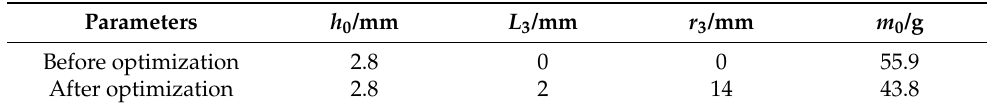
Table 6. Comparison of parameters before and after